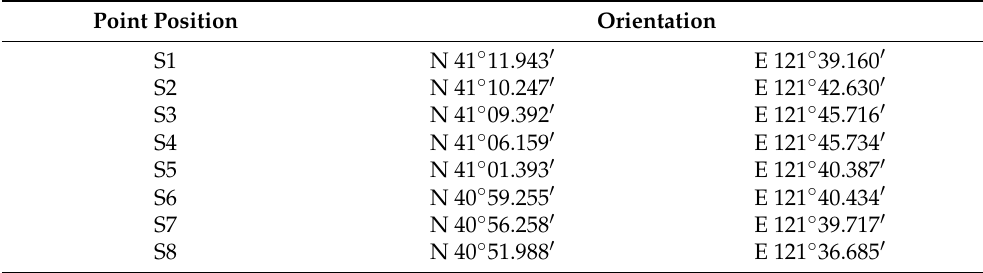
Table 1. Sample site